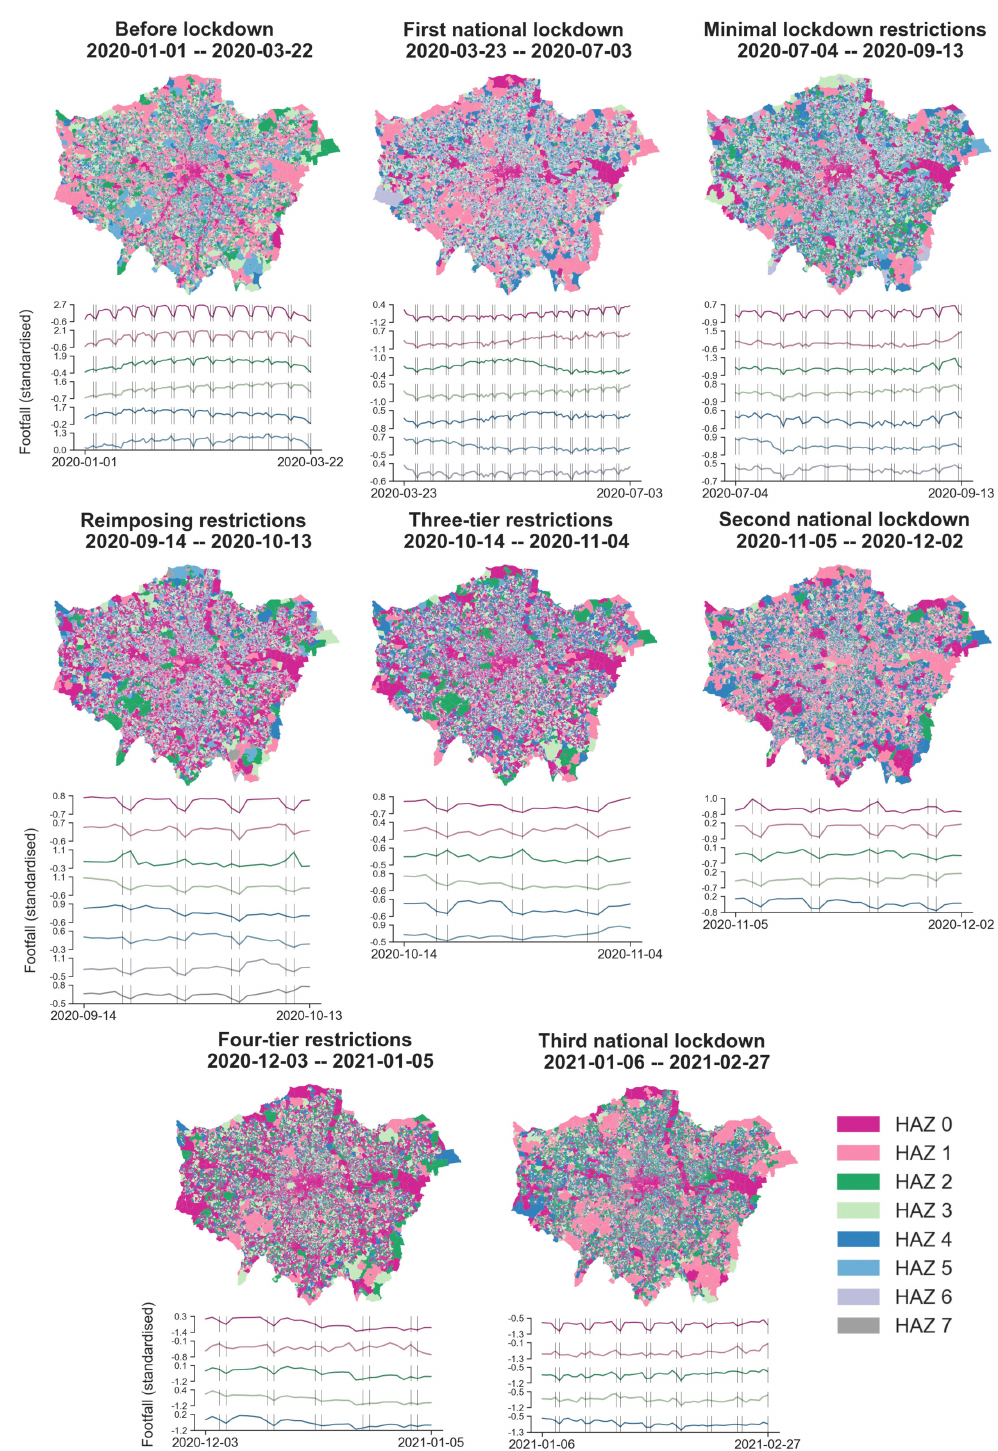
Fig 6. HAZs of Greater London in eight distinctive policy restriction phases. For each phase, the HAZs are extracted from footfall patterns, and the HAZ numbers are 6, 7, 7, 8, 6, 5, 5, 5, respectively. The vertical lines in the temporal footfall figures denote weekends. (Geographical boundary data source: Office for National Statistics licensed under the Open Government Licence v.3.0. Contains OS data © Crown copyright and database right 2022. Contains National Statistics data © Crown copyright and database right